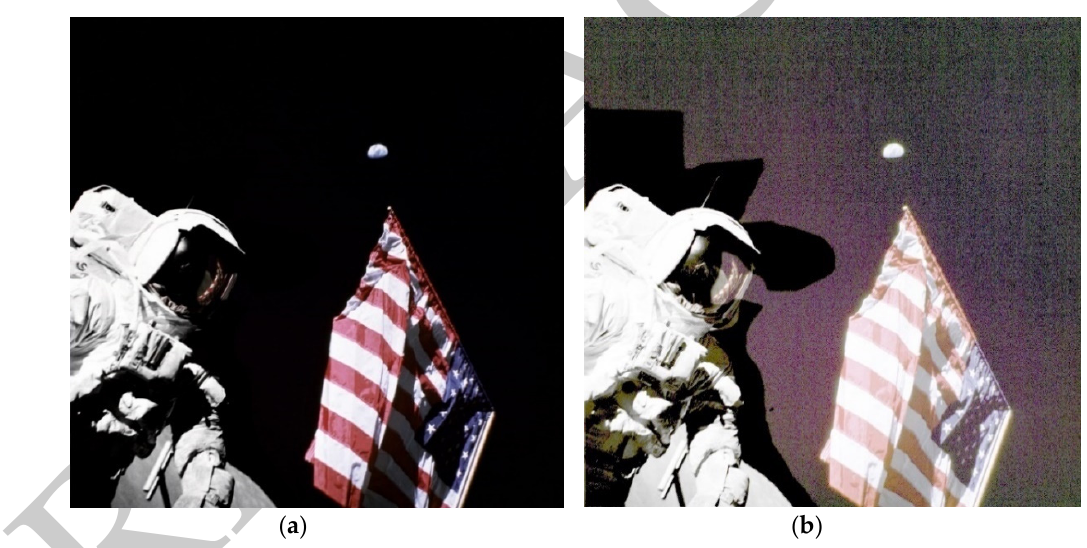
Figure 1. ( a ) According to NASA, the photo shows astronaut-geologist Harrison Schmitt, pilot of the Apollo 17 lunar module, who was photographed near the American flag while reaching the lunar surface. The picture was taken on 13 December 1972 in the Taurus Littrow region. The upper end of the flag points to our planet Earth in the background; ( b ) same photo with increased gamma correction.